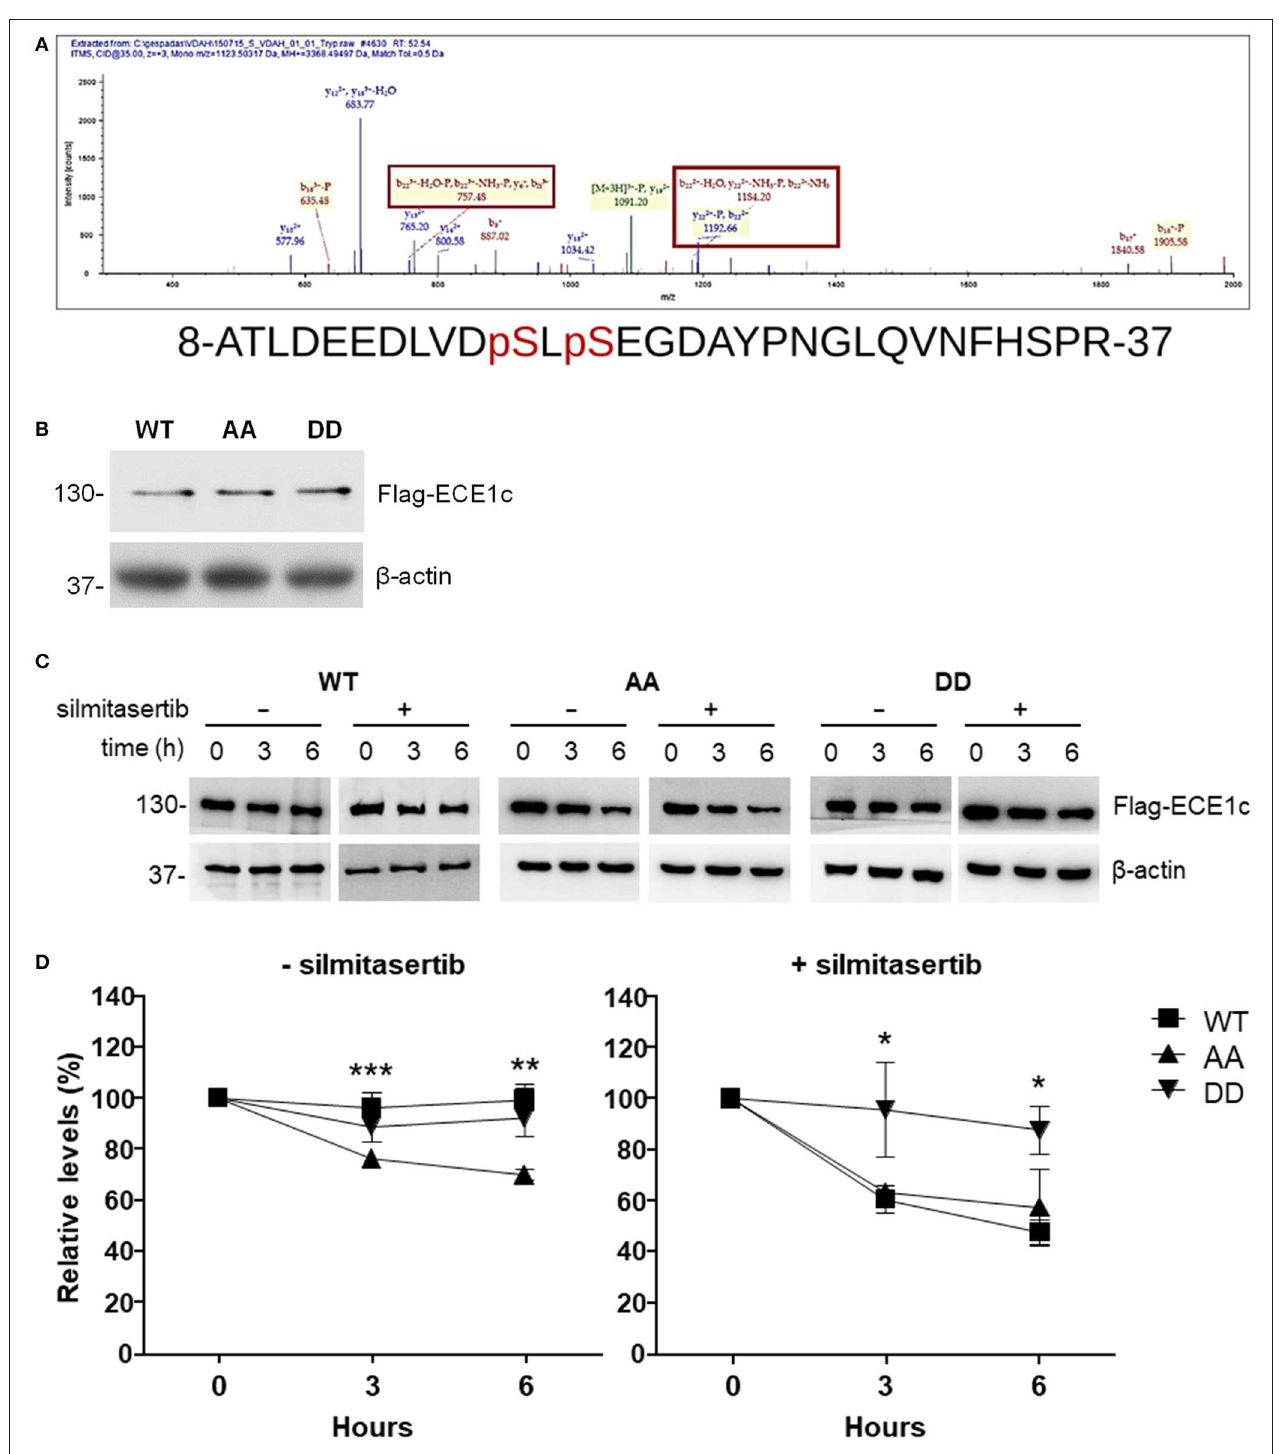
FIGURE 1 | CK2 phosphorylates ECE1c on serines 18 and 20, enhancing its stability. (A) Phosphorylation was performed with commercial human CK2 and recombinant GST-fused N-terminus of ECE1c and ATP as substrates. Samples were analyzed by ESI + -MS. A representative spectrogram of one of the tryptic peptides is shown with phosphorylated serines enclosed in squares. (B) DLD-1 cells overexpressing Flag-tagged ECE1c WT , ECE1c AA , or ECE1c DD were grown for 12h under normal conditions and 10 µ g of total lysates were analyzed by Western blot with an anti-Flag antibody using β -actin as loading control. (C) Cells were grown for 12h and then incubated with 20 µ g/ml cycloheximide (CHX), with or without 25 µ M silmitasertib, during the indicated times. Detection of ECE1c proteins was performed as in (B) . Representative blots are shown. (D) Relative levels of Flag-ECE1c proteins from 3 independent experiments as in C were evaluated. Graphs represent mean ± SEM; * p < 0.05, ** p < 0.01, and *** p < 0.001 (for AA vs. DD).